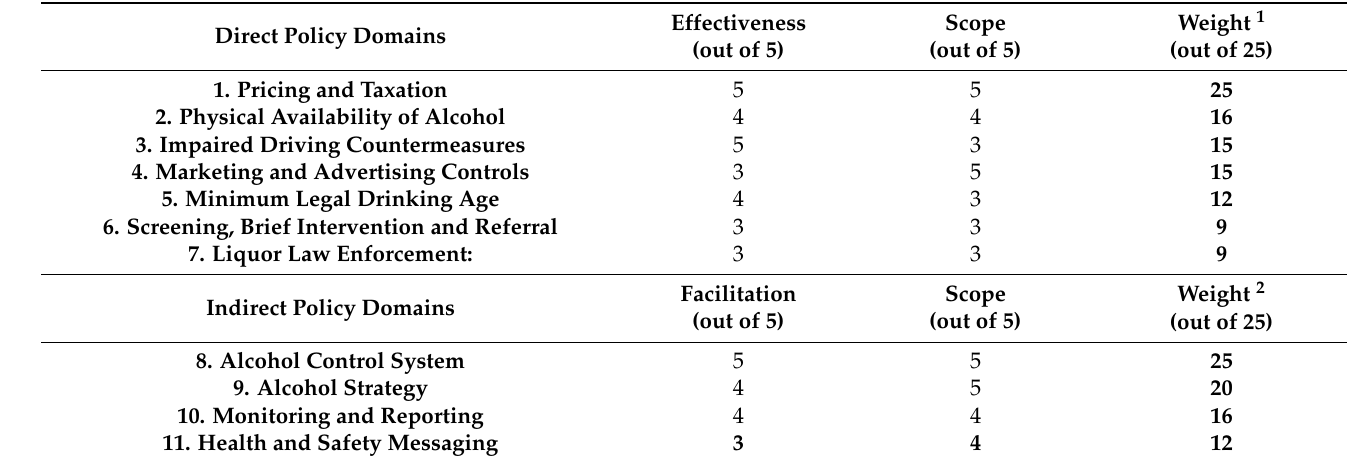
Table 1. CAPE provincial and territorial alcohol policy domains and